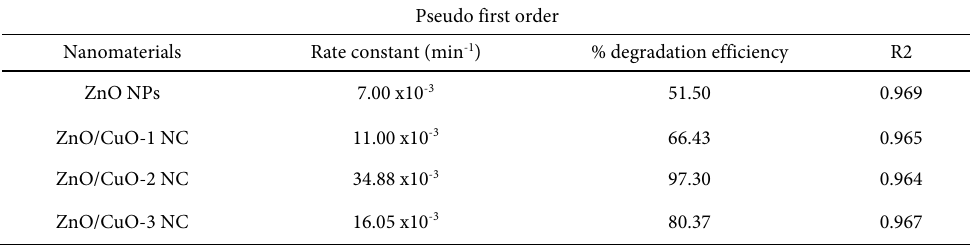
Fig.9. The plot of (a) ln(C /C ) vs irradiation time (t) of BCB degradation of ZnO NPs and ZnO/CuO composites and (b) bar diagram 0 t Fig. 9 The plot of (a) ln(C 0 /C t ) vs irradiation time (t) for BCB degradation over ZnO NPs and ZnO/CuO for rate constants for BCB degradation by ZnO NPs and ZnO/CuO composites. nanocomposites and (b) bar diagram for the rate of constants for BCB degradation by ZnO NPs and ZnO/CuO Table.3. Pseudo-first-order kinetics data values for ZnO NPs and ZnO/CuO nanocomposite